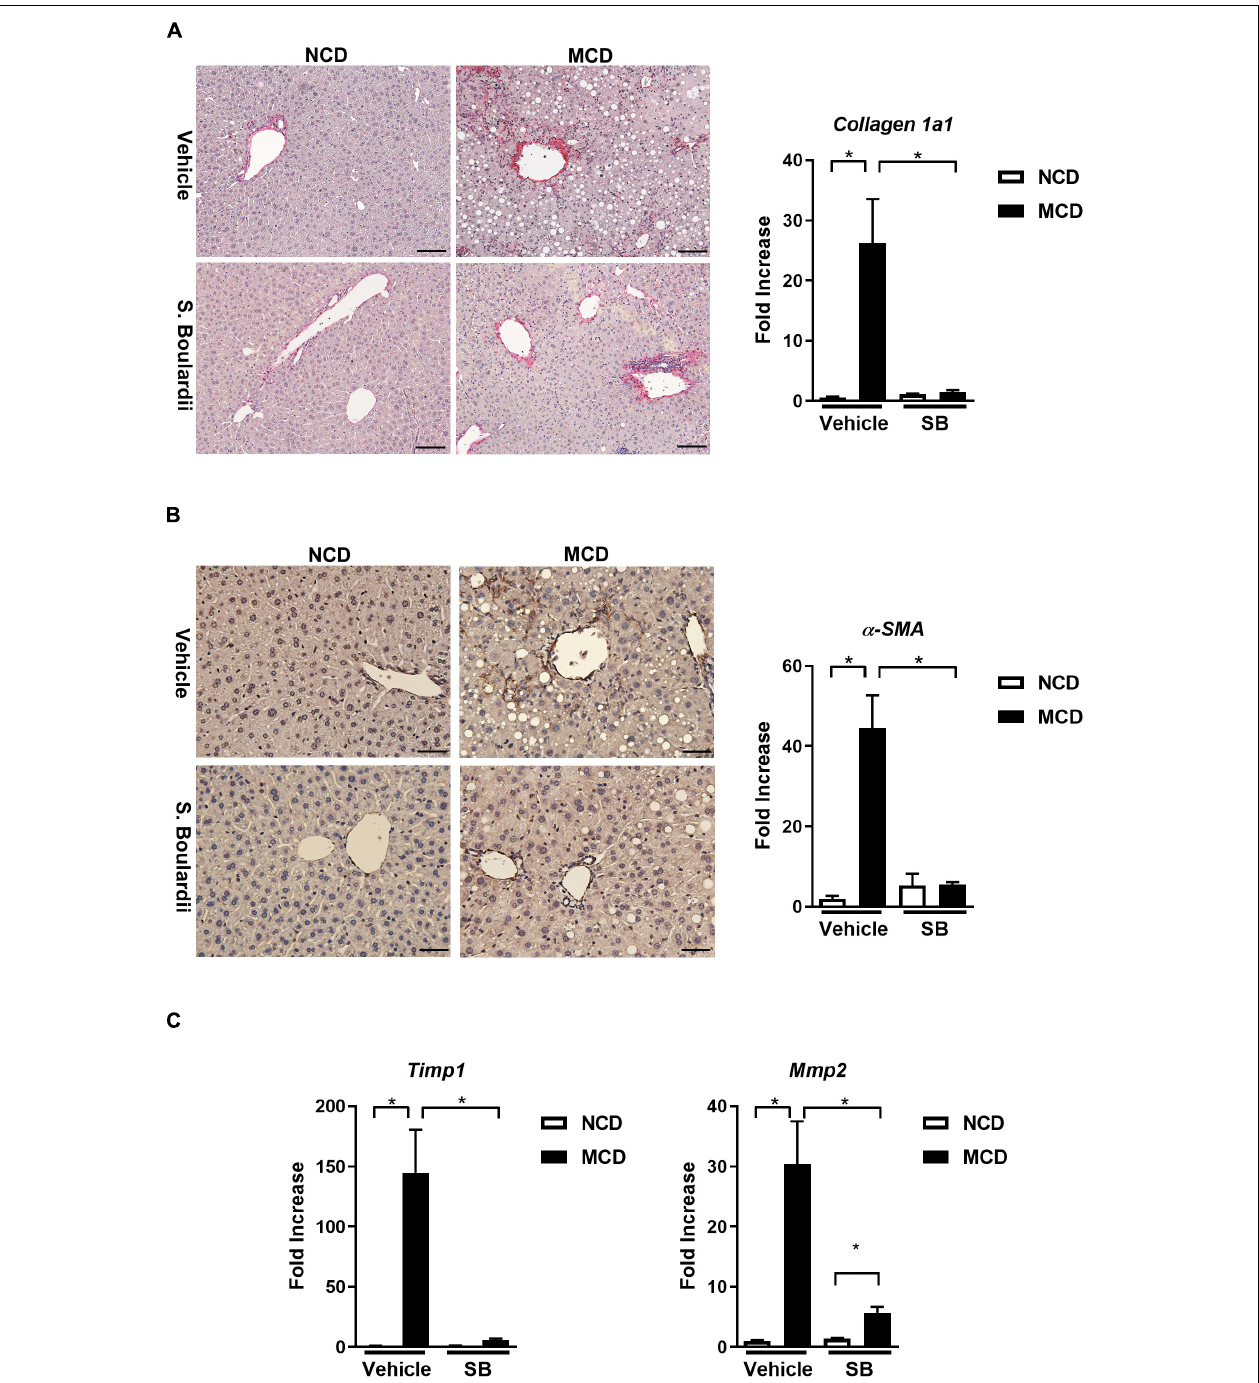
FIGURE 3 | SB ameliorated MCD diet-caused hepatic fibrosis in mice. (A) Representative sections of Sirus Red staining (Scale bar: 100 µ m) and hepatic c ollagen 1a1 expression. (B) Representative sections of immunohistochemical staining of α -SMA (Scale bar: 50 µ m) and hepatic expression of α -SMA. (C) Hepatic fibrotic gene expressions, Tissue Inhibitor of Metalloproteinase 1 ( Timp1) and Matrix Metallopeptidase 2 ( Mmp2) * p < 0.05.